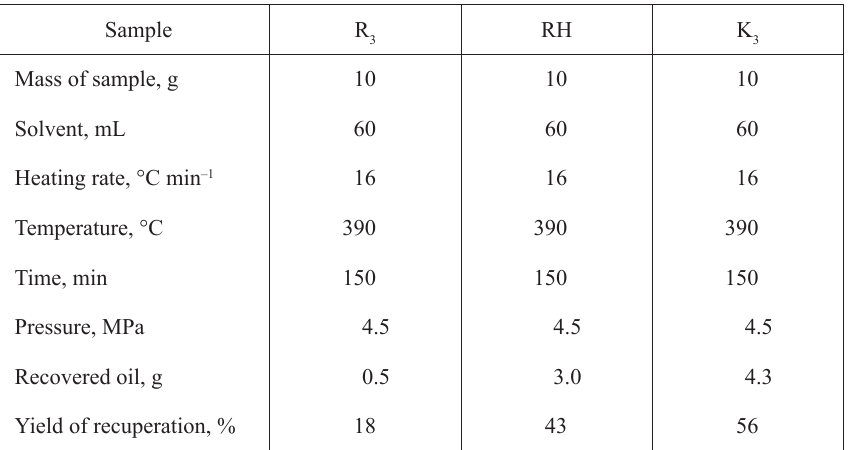
Table 3. Extraction of the treated shale by toluene